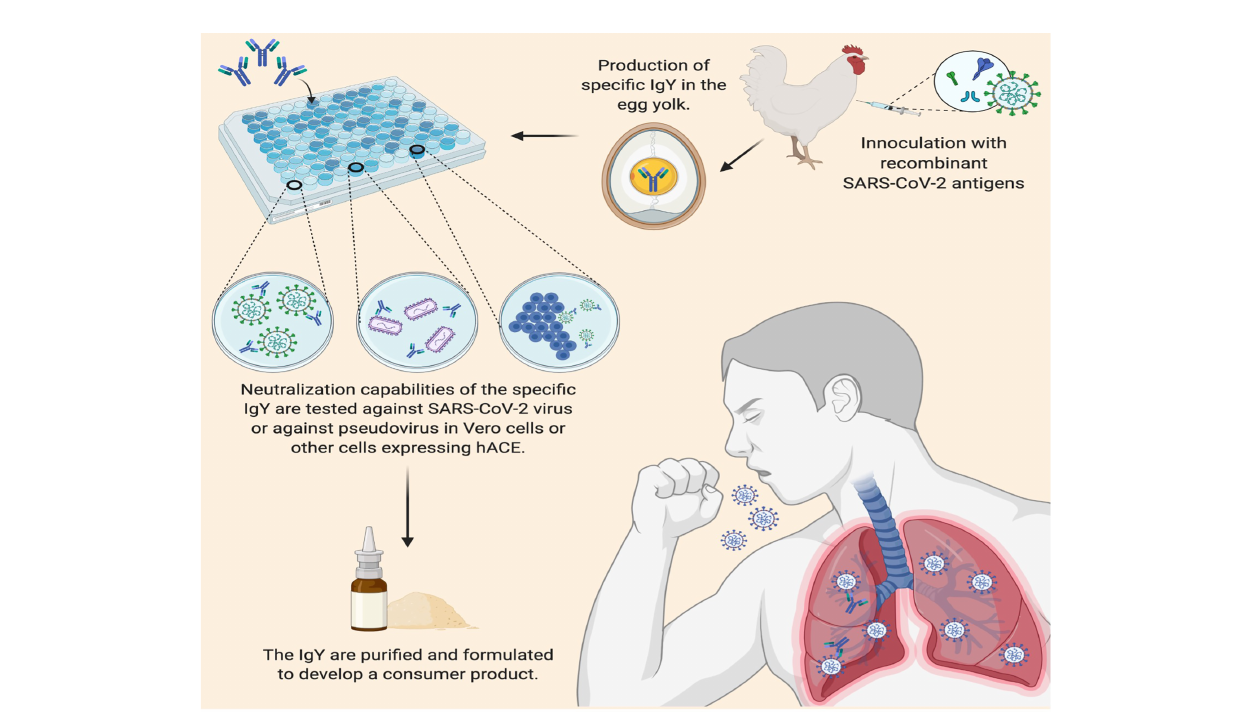
FIGURE 3 | Applications of Immunoglobulin Y against SARS-CoV-2 to Inhibit COVID-19. IgY can be easily produced by inoculating egg-laying hens with recombinant SARS-CoV-2 antigens such as the spike protein on the viral envelope. Following a second inoculation, the yolk of the eggs laid by commercial hens contains 50-100 mg IgY per egg; up to 500 mg IgY per egg can be obtained from naïve, speci fi c-pathogen-free hens. After harvesting the IgY from the egg yolks, the ef fi cacy of IgY antibodies can be tested for neutralization activity before puri fi cation and processing into a lyophilized product to be evaluated in controlled trials as a potential (prophylactic) COVID-19 passive